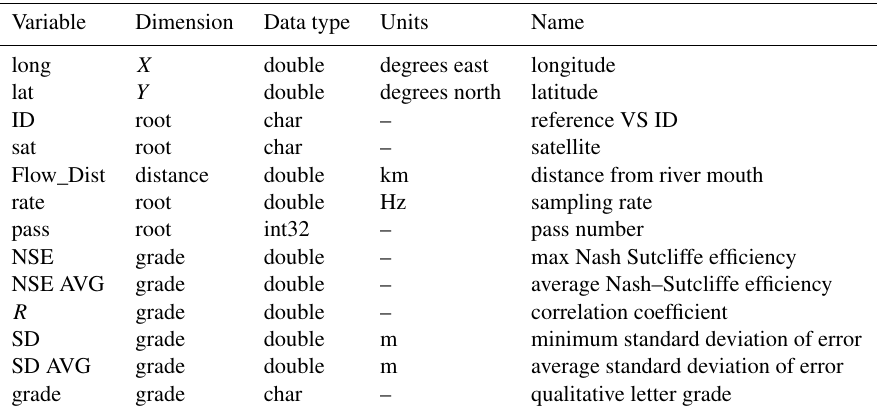
Table A1. The global variables are longitude and latitude of the center of the virtual station, the virtual station ID, the satellite name, flow distance, sampling rate, the satellite pass number and a suite of fit statistics, or a qualitative letter grade. Qualitative letter grades were assigned based on amount of data points, seasonal pattern, and similarity to nearby VS. This was done only when validation data were unavailable. When validation was possible, the VS was evaluated with all gages on the river through relative height comparison. Maximum Nash–Sutcliffe efficiency (NSE), average NSE, maximum R (correlation coefficient), minimum standard deviation of error (SDE), and average SDEs are reported.